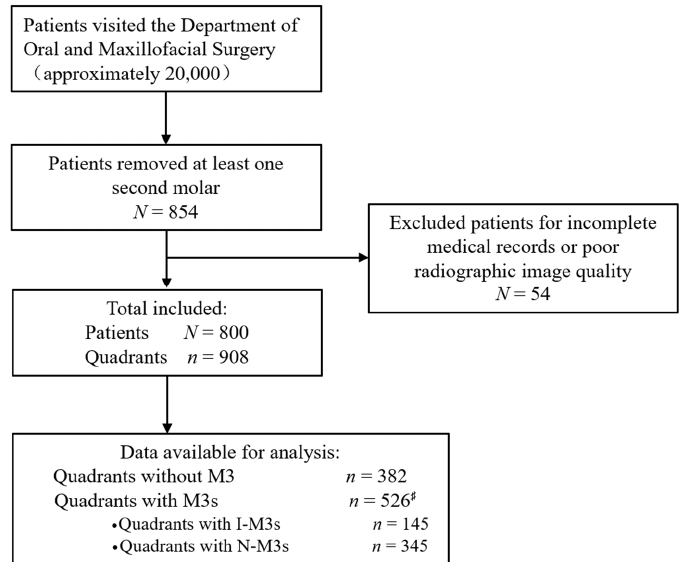
Figure 1. Flow chart of the study design. ♯ : including 145 quadrants with I-M3s, 345 quadrants with N-M3s and 36 quadrants with M3s that were residual roots or microdontia.